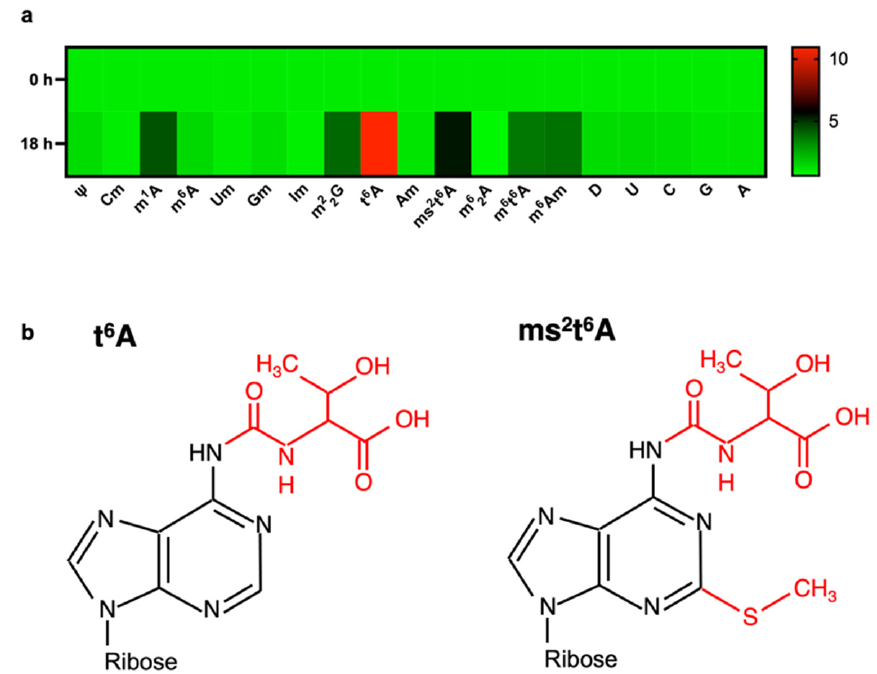
Figure 1. Screening of candidate modified nucleosides by SARS-CoV-2. ( a ) Heatmap analysis of modified nucleoside levels in extracted RNA from SARS-CoV-2-infected HEK293 cells. Color scale shows the auto-scaled relative mean of n = 3 biological replicates. ψ : pseudouridine; Cm: 2 ′ -O-